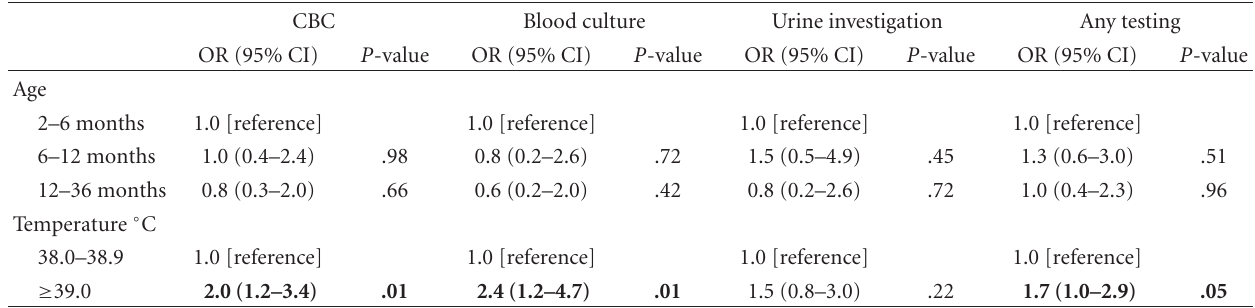
Table 4: Adjusted odds ratios (OR) from multivariable logistic regression for obtaining laboratory tests in patients with acute otitis media and temperature ≥